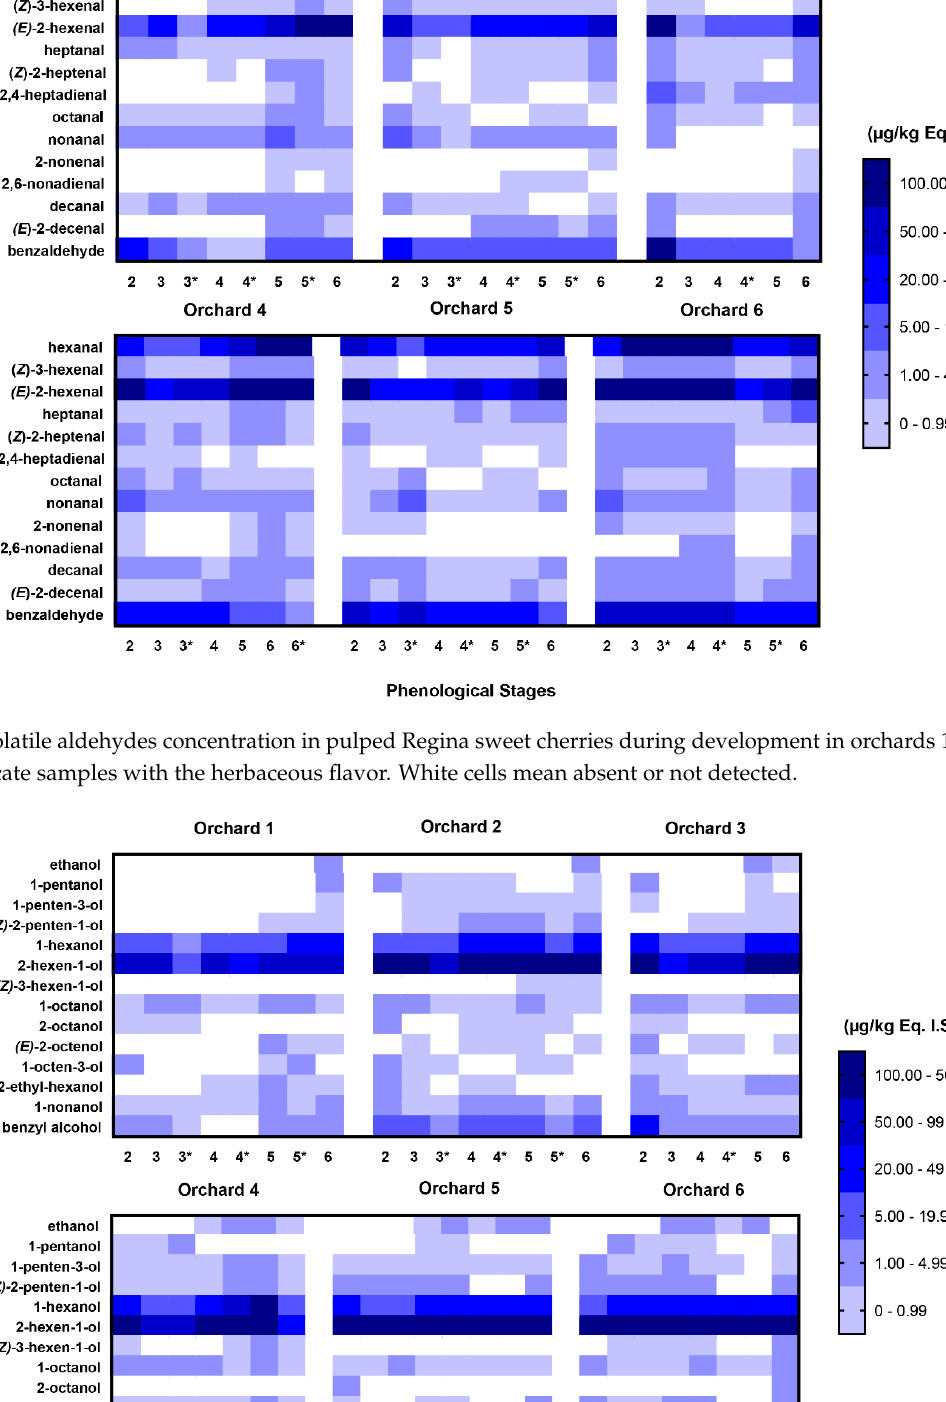
Figure 5. Other volatiles concentration in pulped Regina sweet cherries during development in orchards 1 to 6. 3*, 4*, 5* and 6* indicate samples with the herbaceous flavor. White cells mean absent or not detected.